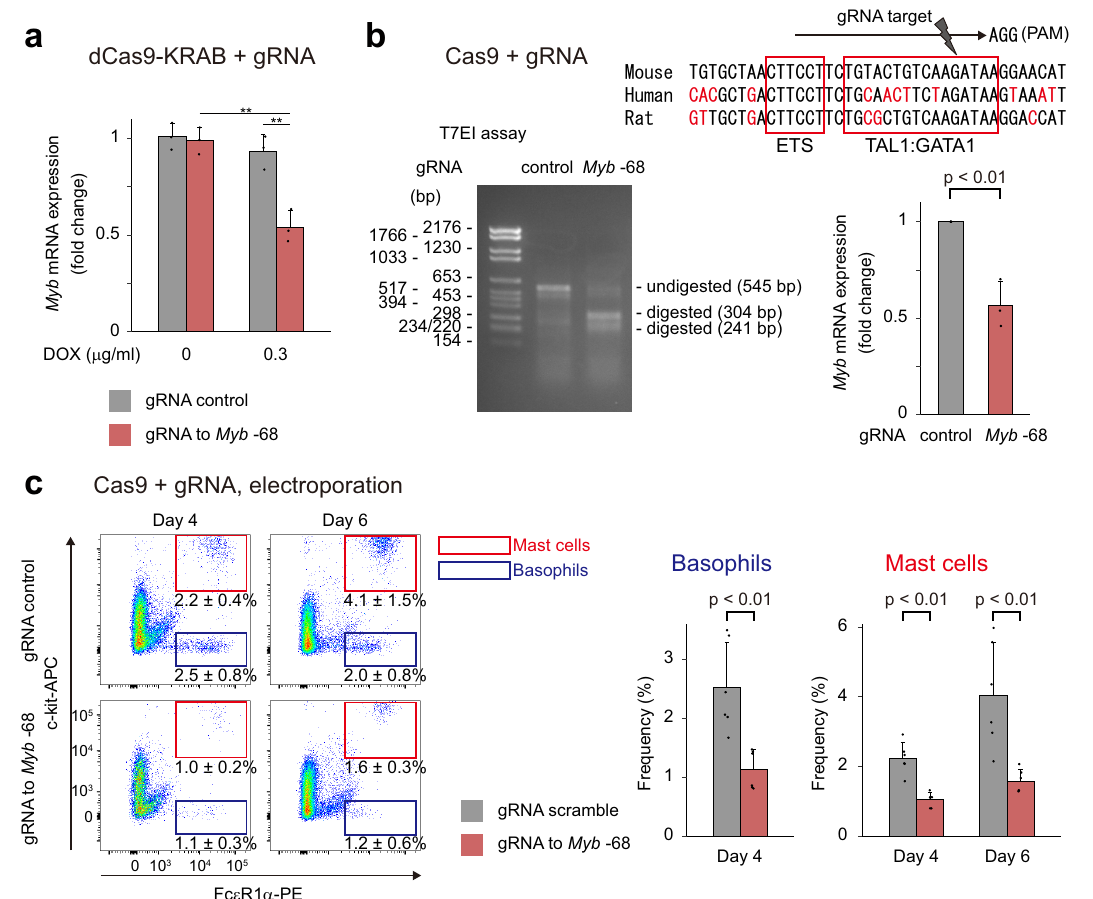
Fig.5|The Myb -68enhancerregulates Myb mRNAexpressionandbasophiland mastcelldifferentiation.a MousemastcellP815cellswereinfectedwithlentivirus harboring dCas9-KRAB and DOX-inducible control gRNA (grey) or gRNA targeted forthe Myb -68enhancer(red),sortedandtreatedwithdoxycycline(0.3ng/ml)for 72hours. n =3 independent experiments. Data are presented as mean values±SD. p =2.4×10 − 4 by one-way ANOVA. ** p <0.01 by the Tukey-Kramer post hoc test. p =5.0×10 − 4 and 1.2×10 − 3 from left to right. b P815 cells were infected with lenti- virusharboring Cas9 and DOX-inducible controlgRNA(grey)orgRNAtargeted for the Myb -68 enhancer (red). Cells were sorted and treated with doxycycline (1ng/ ml) for 72h. Genome editing ef fi ciency was evaluated by T7EI mismatch detection assay (left), and Myb mRNA expression was analyzed by qPCR (right). n =3 inde- pendent experiments. Data are presented as mean values±SD. p =0.0037 by two- tailedStudent ’ s t -test.TheupperpanelshowsthecompoundbindingmotifofTAL1